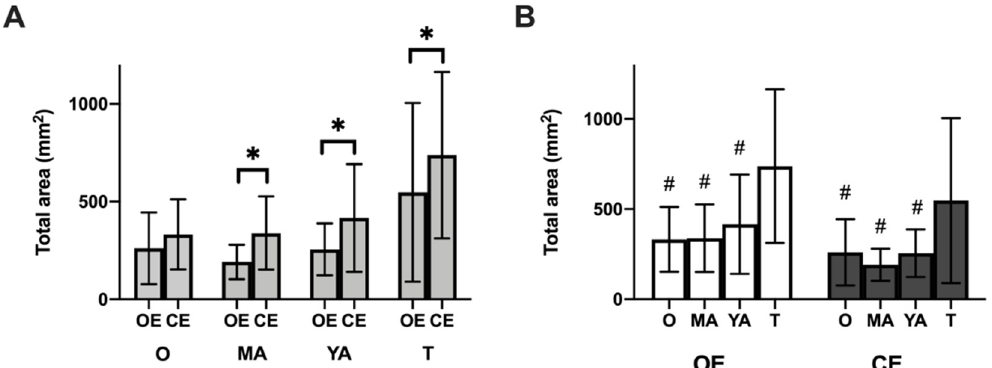
Figure 3. Scores on the balance test for the variable total area of center or pressure. ( A ) Comparison by testing conditions (open eyes vs. closed eyes) and ( B ) Comparison by age group. Lower values are associated with better performance on the task. O: Older adults; MA: middle-aged adults YA: young adults; T: teenagers; OE open eyes; CE: closed eyes. * p < 0.001. # post hoc differences only vs. the group of teenagers, p < 0.001.